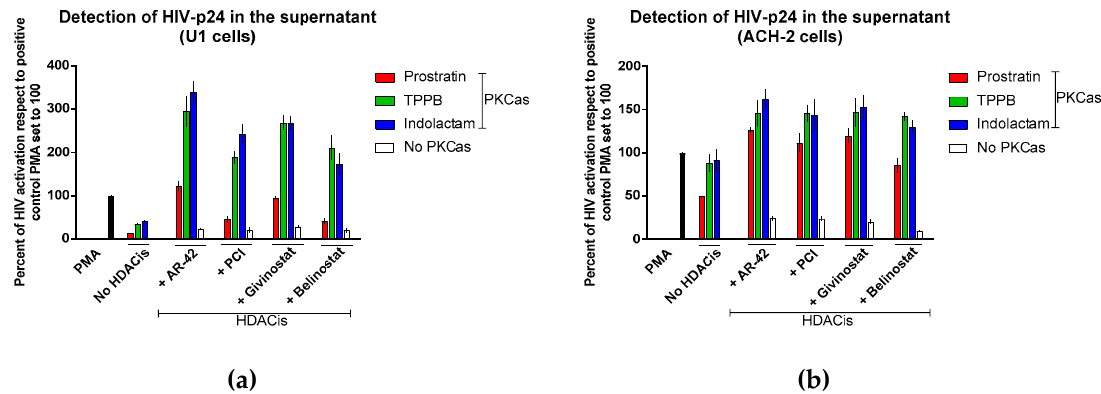
Figure 3. Effect of combinations of LRAs on the reactivation of latent HIV. The HIV reactivation was measured using ELISA: ( a ) U1 cells and ( b ) ACH-2 cells. Cells were treated with LRAs alone, or in combination, for 48 h, cells induced with PMA were used as a control. The HIV expression was measured by detection of the viral Gag p24 released in the supernatant and expressed as a percentage of the positive control PMA set to 100 (black columns). Red columns represent cells treated with prostratin in combination with or without HDACis; green columns are cells treated with TPPB in combination with or without HCDAis; blue columns are cells treated with indolactam in combination with or without HDACis; and white columns are cells treated with a single HDACi. Data are shown as mean ± S.D. of three independent experiments.